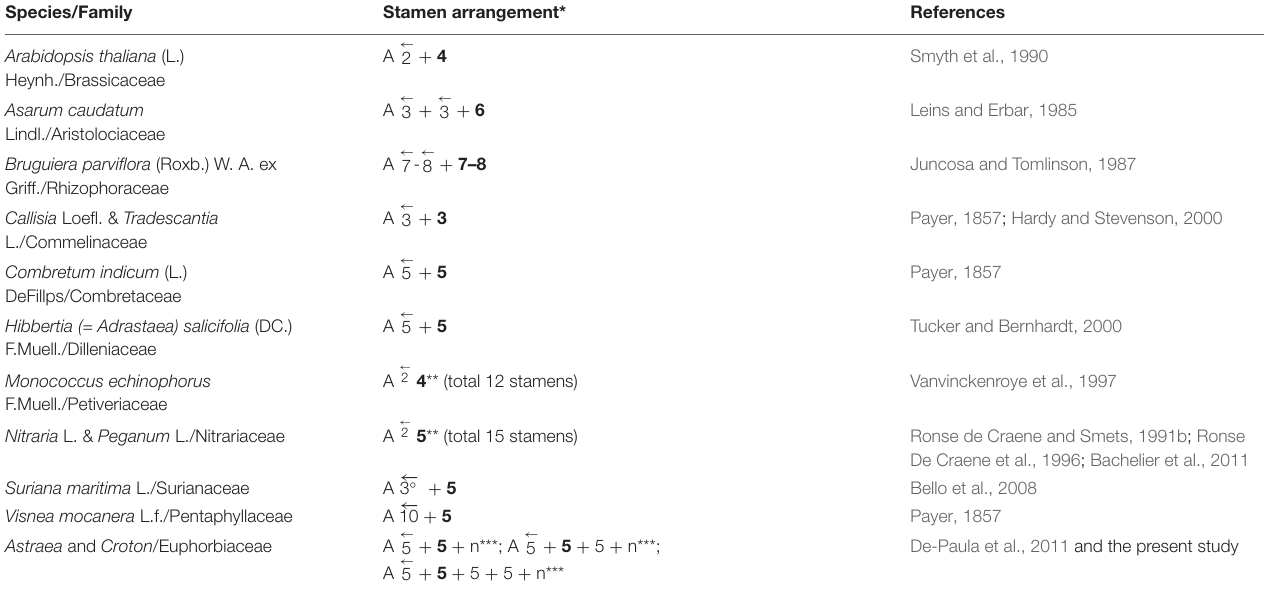
TABLE 2 | Examples of centrifugal stamen development in oligandric and lower-polyandric flowers. Species/Family Stamen